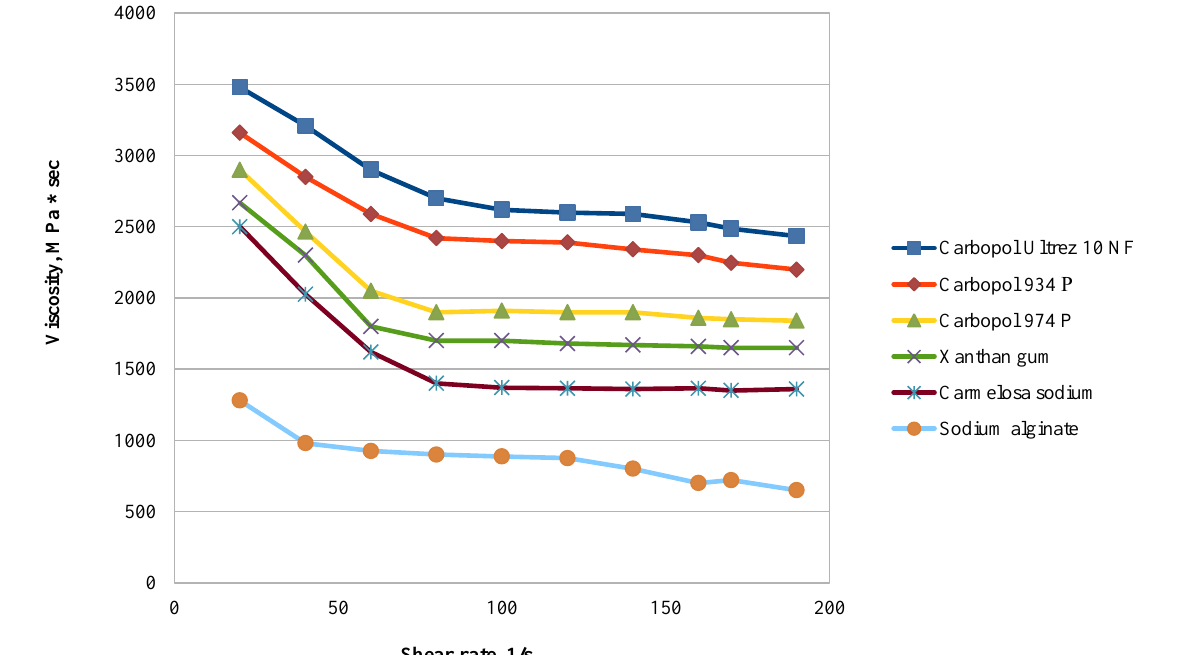
Fig. 1.The dependence of the structural viscosity of the gel samples on the shear rate